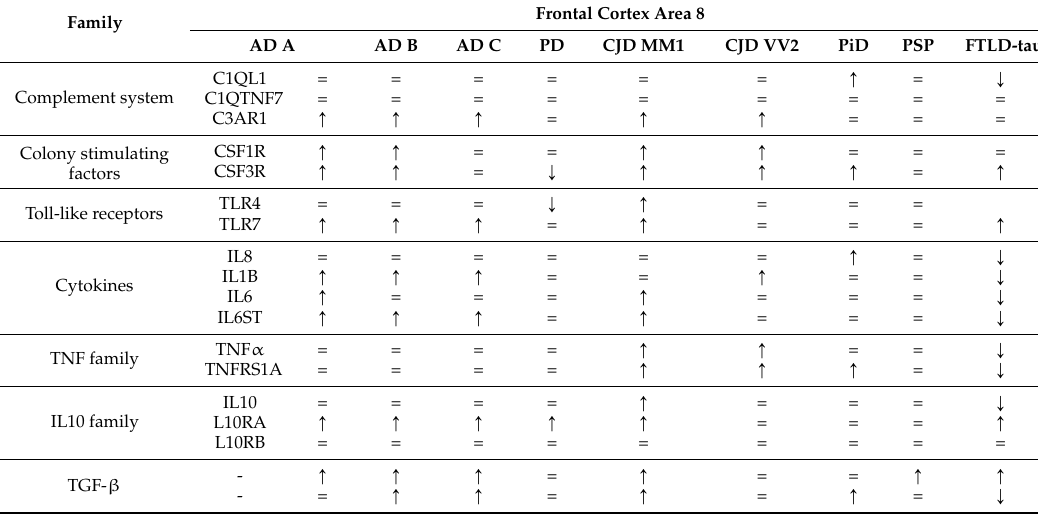
Table 1. Summary of gene regulation in the frontal cortex are 8 in Alzheimer’s disease (AD) at stages A.; B and C.; Parkinson’s disease (PD); Creutzfeldt-Jakob disease (CJD) subtypes MM1 and VV2.; Pick’s disease (PiD).; progressive supranuclear palsy (PSP).; and frontotemporal lobar degeneration linked to mutation P301L in MAPT